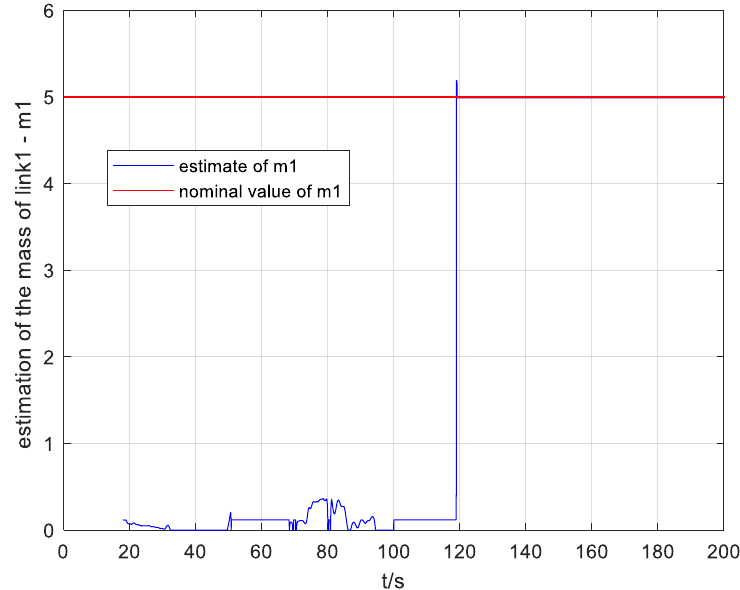
( b ) Figure 3. ( a ) The theoretical value and calculated value of 𝐷 11𝑖 ; ( b ) the theoretical value and calculated value of 𝐷 21𝑖 . It can be seen from Figure 2 and Figure 3 that, with the fundamental frequency 𝑓 0 = 0.01𝐻𝑧 as the sampling interval and 10 consecutive components, the coefficient 𝑠 of the steady state components of the joint angular position can be accurately estimated based on (48) and (60).